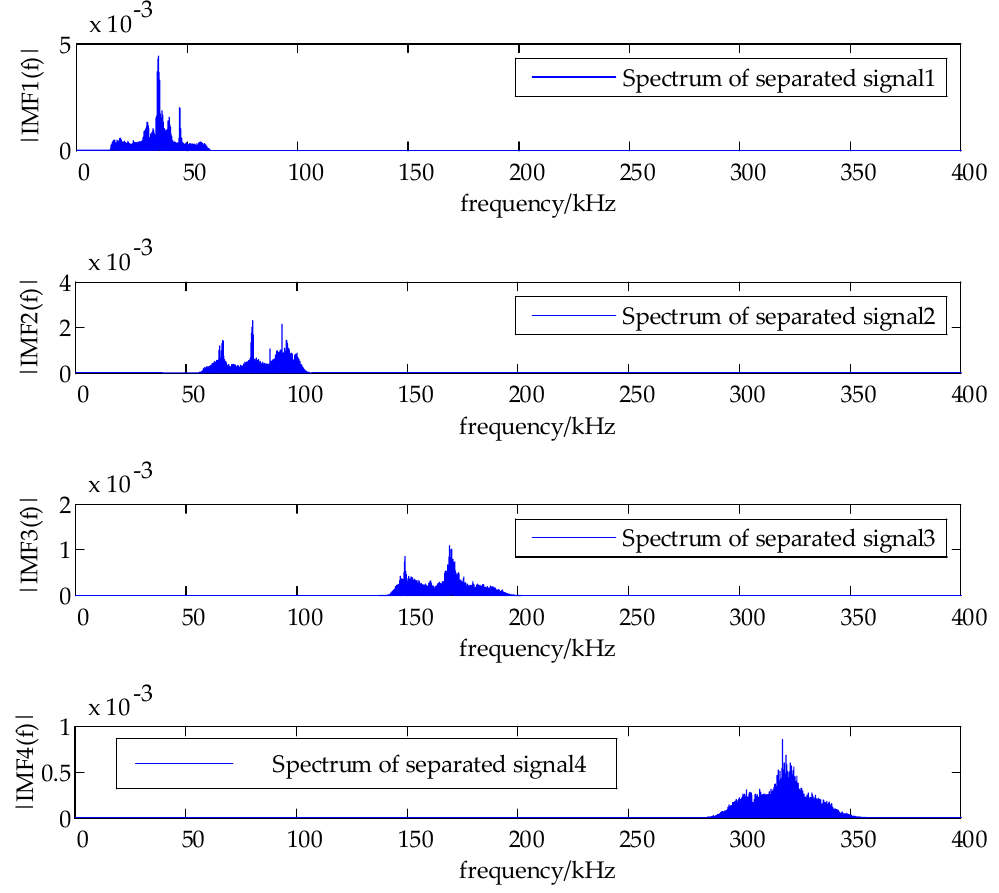
Figure 19. The spectrum of separated signals of sensor 2.